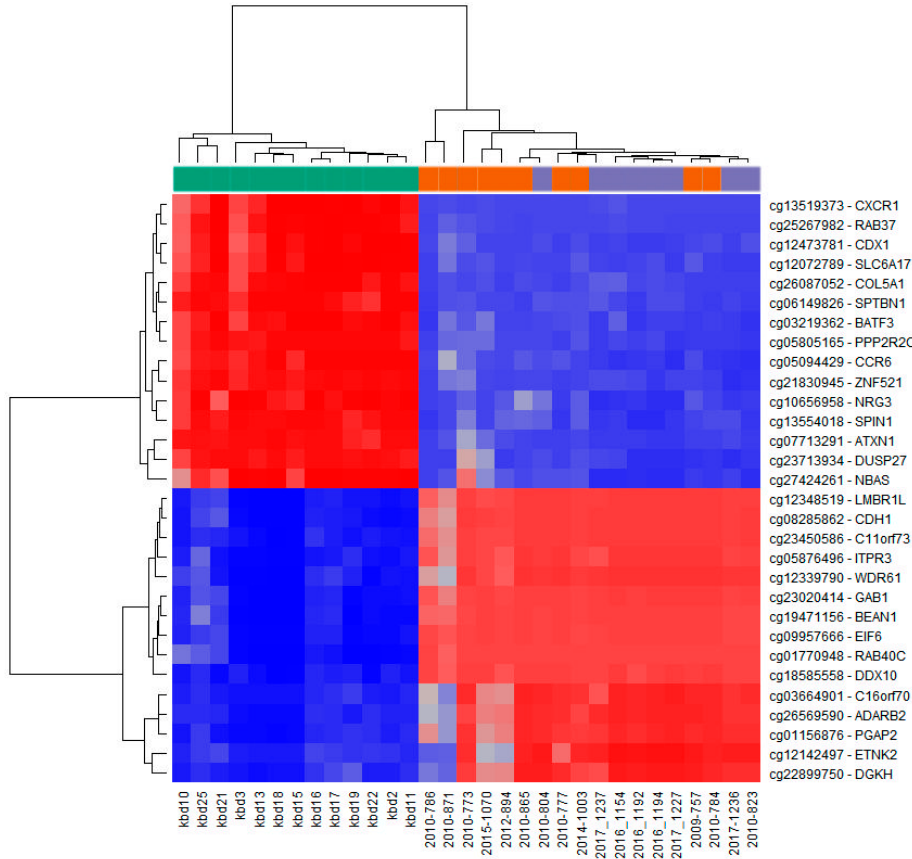
Figure 3. Infinium MethylationEPIC BeadChip findings: Heatmap representation of samples clustering for the top fifteen hypermethylated (blue) and top fifteen hypomethylated (red) CpG sites in cancer tissue compared to control healthy tissue (according to the methylation difference value; Tables 3 and 4). Left side (green): HNSCC samples ( n = 13; kbd10–kbd11); right side (violet): Healthy oral